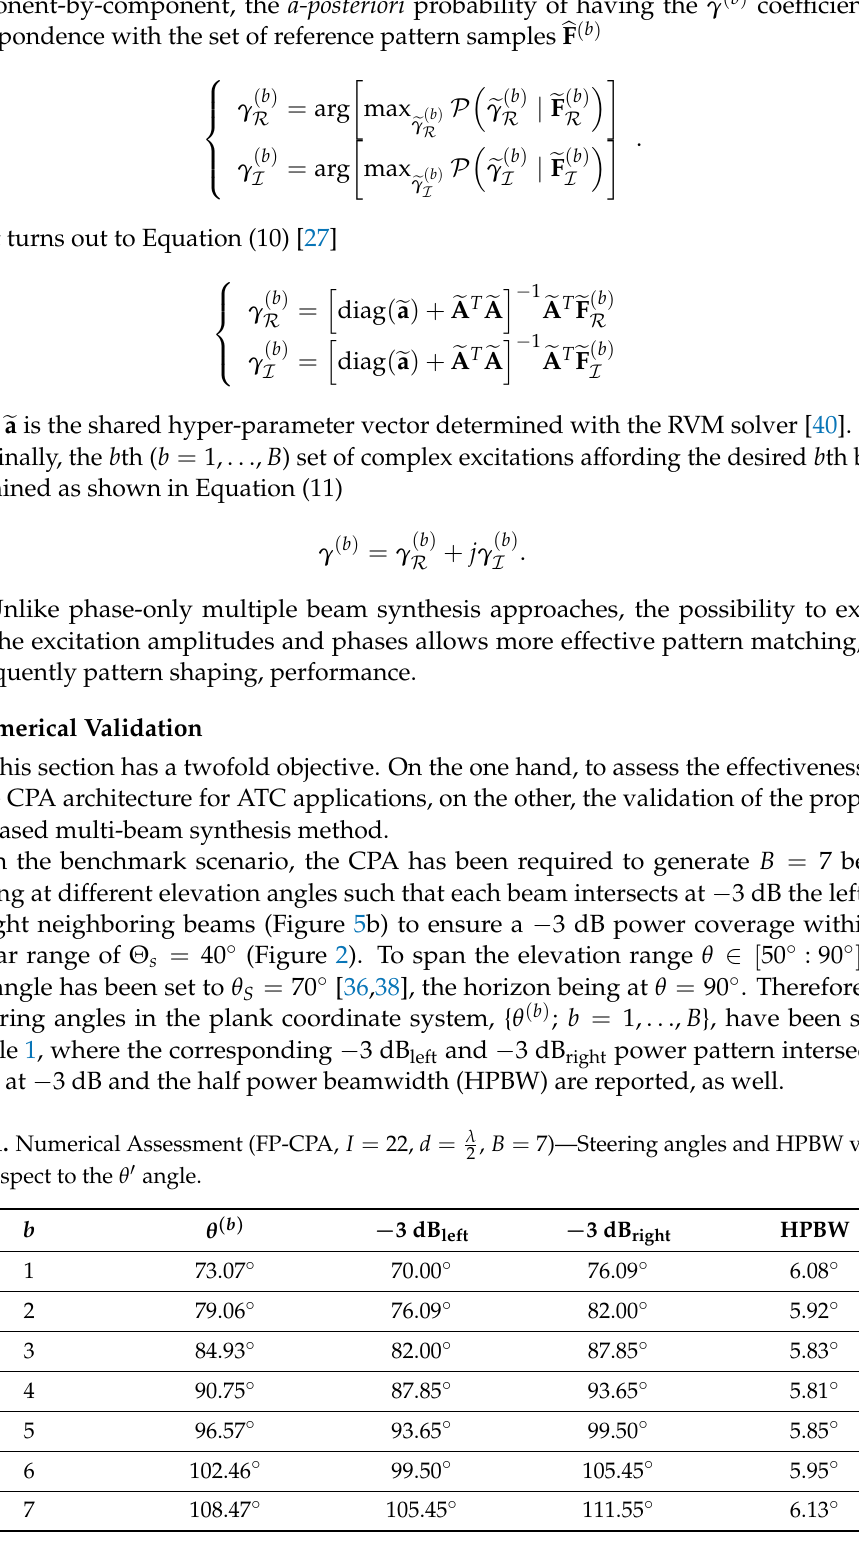
, B = 7)—Steering angles and HPBW values 2